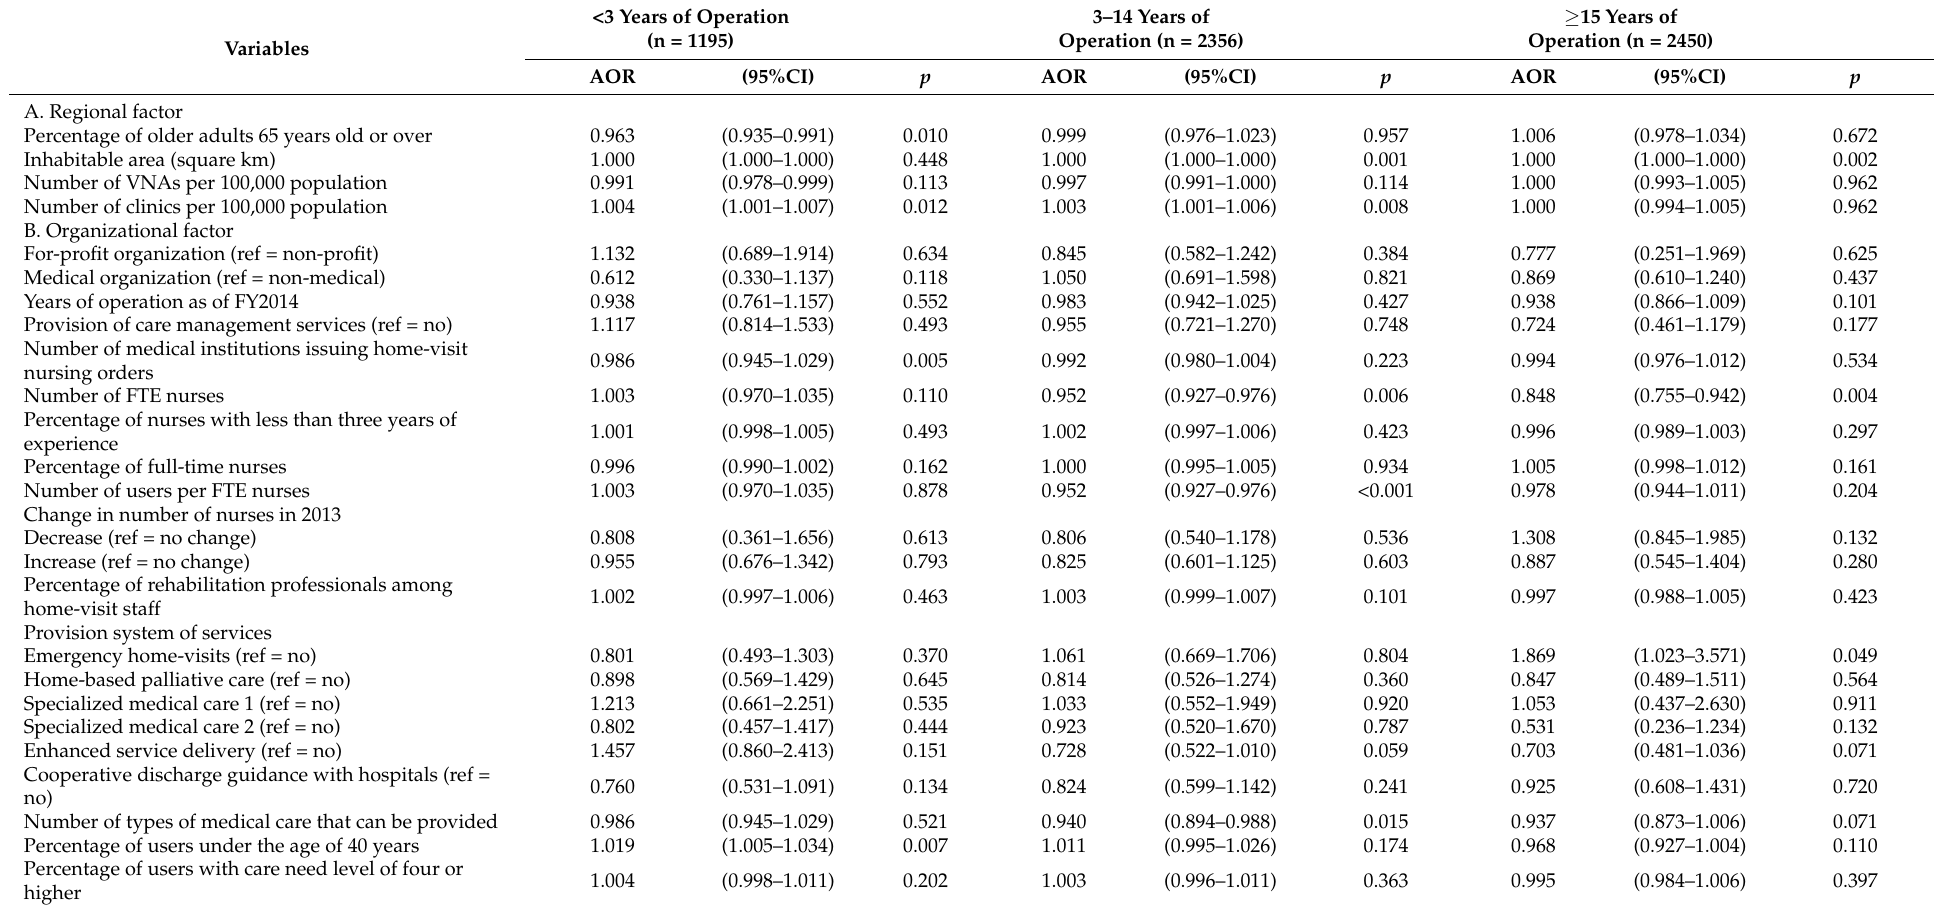
Table 3. Multivariable logistic regression analysis on the factors related to the closure of home-visit nursing agencies by years of